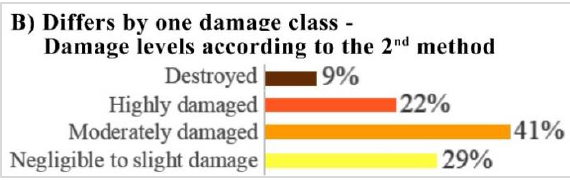
Figure 14. Difference by one damage class between the two DDEs: percentage of buildings that had a certain damage class according to the assessment of the 2 nd method.